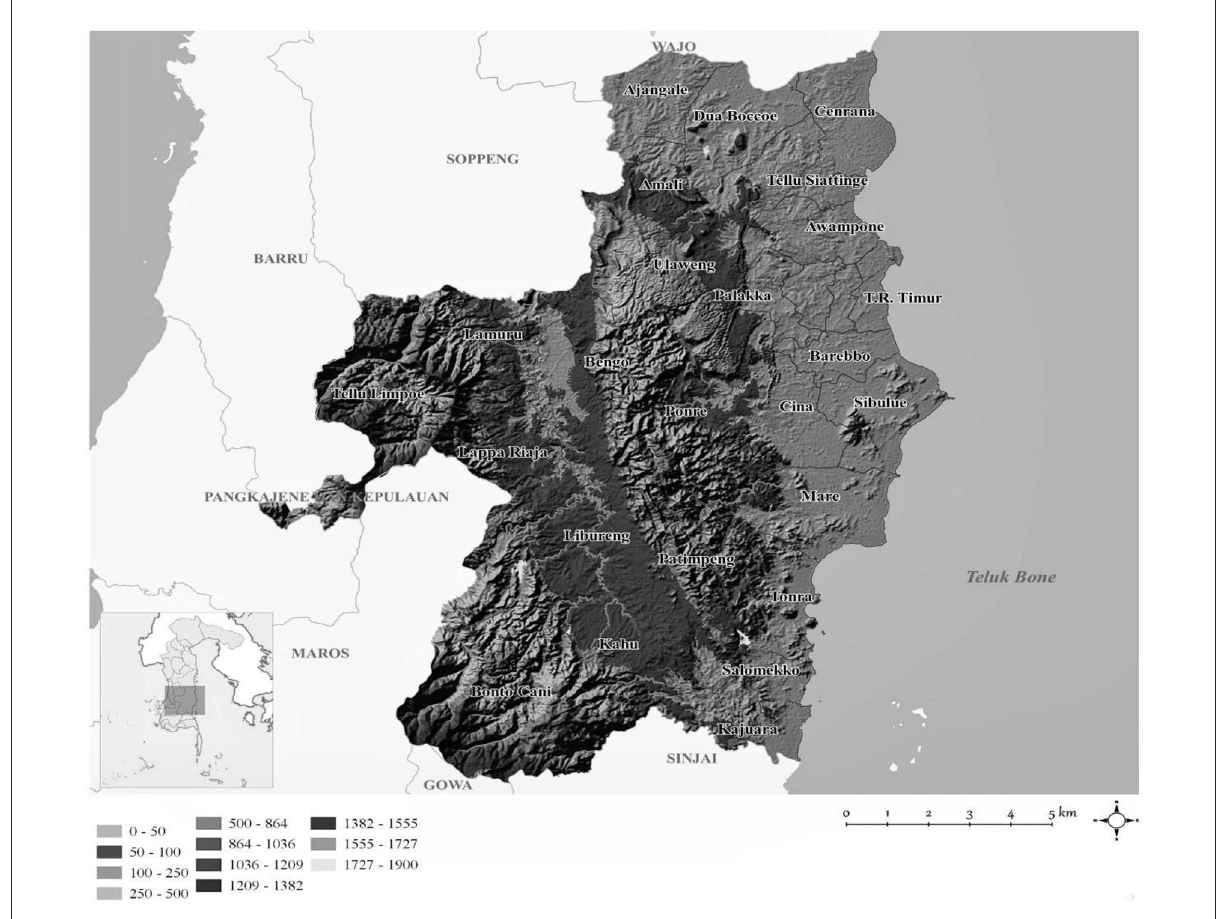
FIGURE1 Bone Regency,